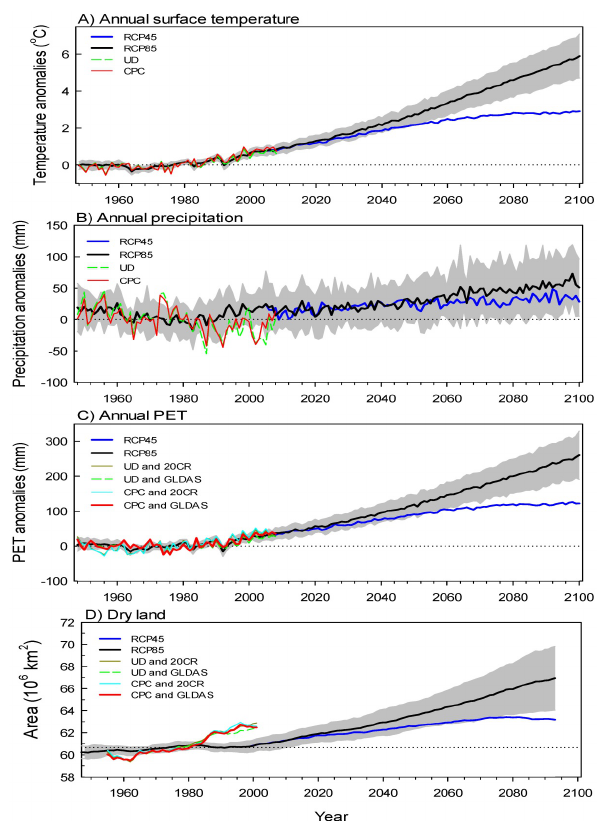
Fig. 4. Temporal variations of annual mean (a) surface air temper- ature, (b) precipitation, and (c) PET, averaged over land between 60 ◦ N and 60 ◦ S, and (d) total area of global drylands. Thick black (blue) lines are the ensemble average of the 27 models from his- torical/RCP8.5 (RCP4.5) simulations. Dotted line shows the clima- tology of 1961–1990. The grey shading denotes one standard devia- tion of the 27 models from historical/RCP8.5 simulations. In (a) and (b) , the observations from CPC (UD) data are shown as red (green dashed) lines. In (c) and (d) , the observational results from com- binations of UD or CPC, with 20CR or GLDAS indicate that the temperature and precipitation are from UD or CPC, and the solar radiation, humid and wind speed are from the 20th century reanal- ysis or